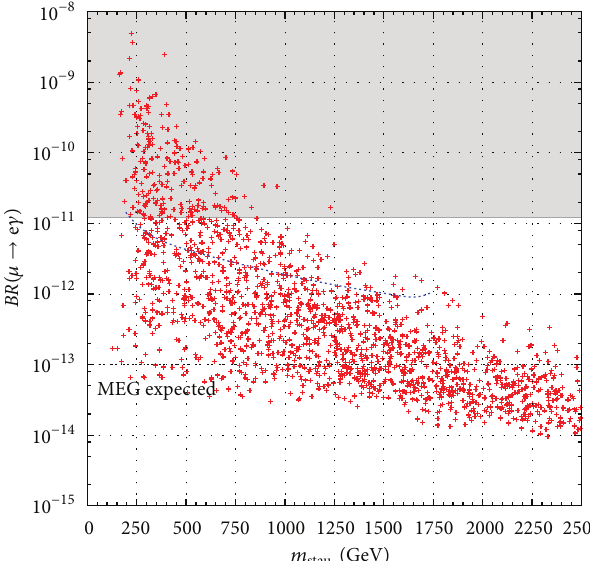
Figure 5: 𝐵𝑅 of 𝜇 → e 𝛾 decay as a function of lightest slepton mass in a SO(10) based SUSY-GUT model. The grey area was excluded by the MEGA experiment [88, 89]. The blue dotted line is a reference case for favoured values of parameters